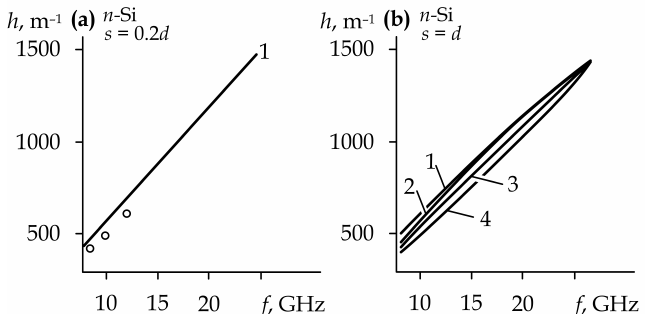
Figure 6. Dispersion characteristics of the main mode (curve 1) and three higher modes (curves 2–4) for the SL with narrow metal strips and the substrate protruding out beyond the strips, when ( a ) s = 0.2 d and ( b ) s = d